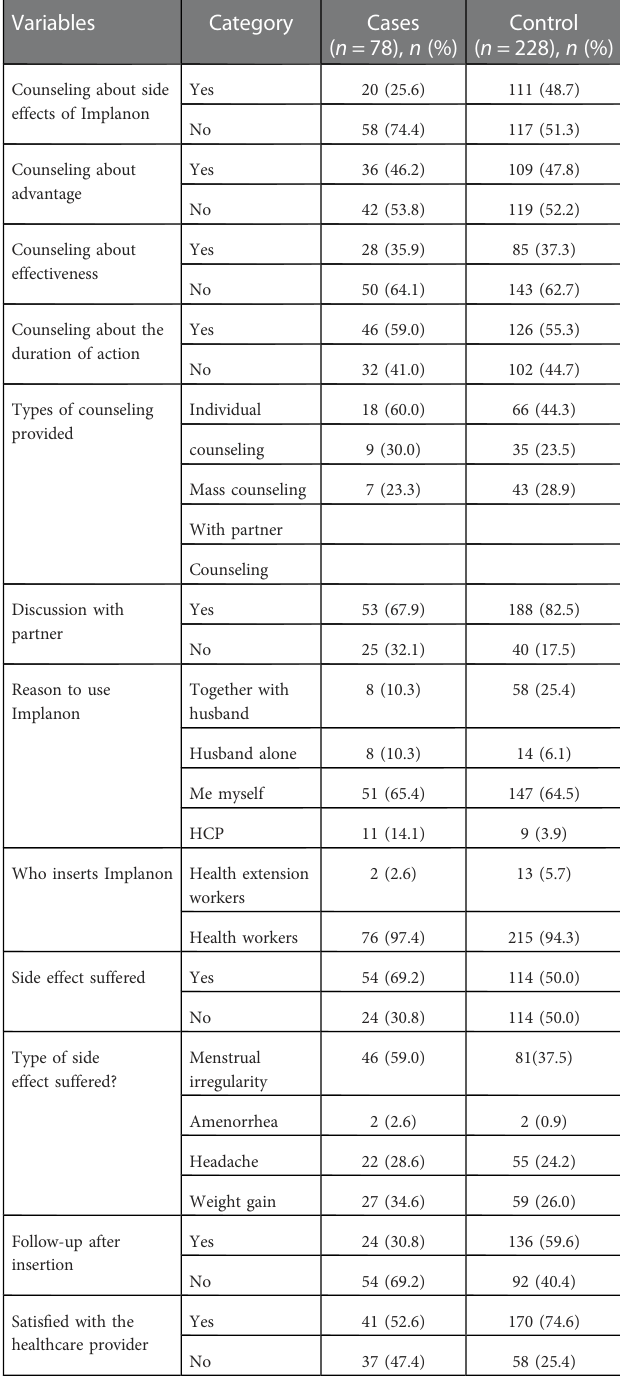
TABLE 3 Characteristics of study participants regarding counseling and other variables, Debre Berhan, Northeast Ethiopia, 2022.